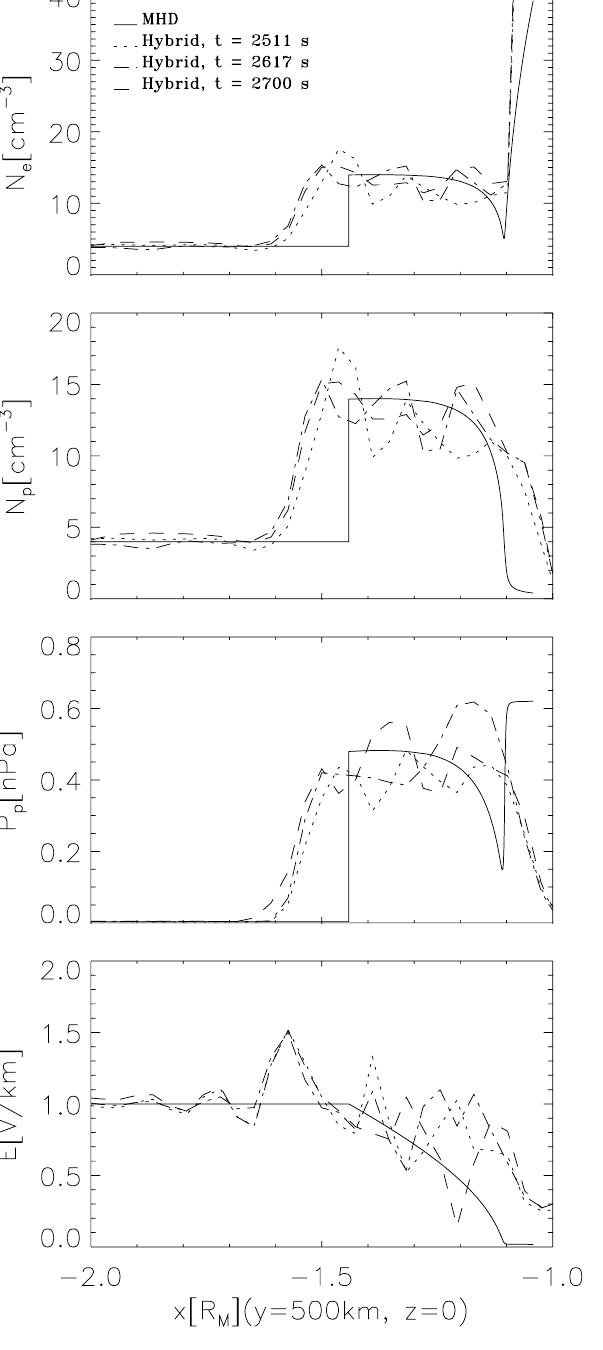
choice of larger values of T e,h will lead certainly to higher MPB